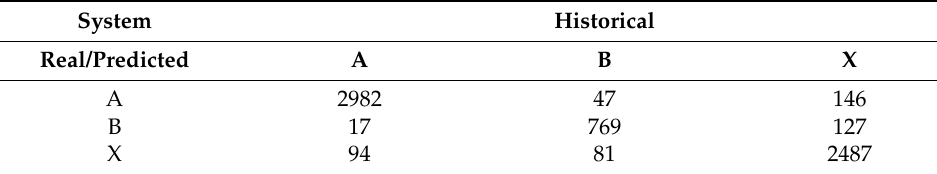
Figure 6. Inference engine of the expert module. Table 2. Confusion matrix.